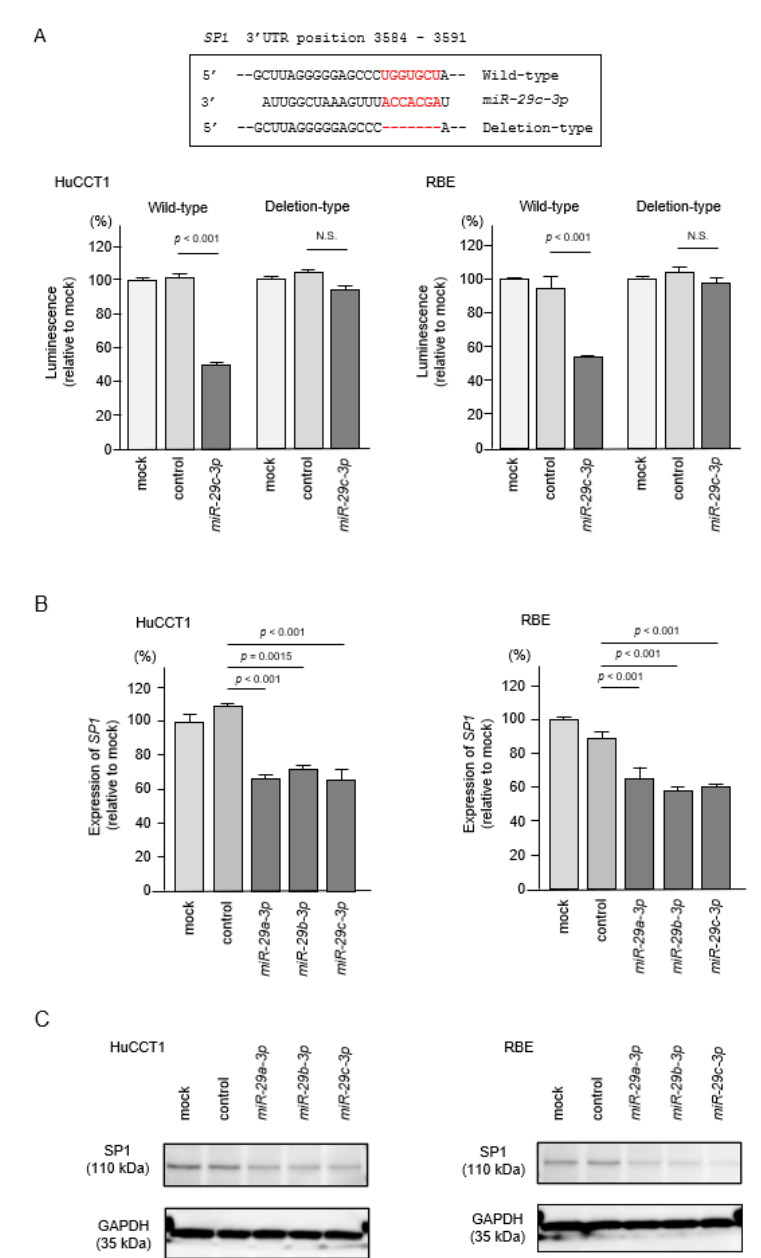
Figure 13. Direct regulation of SP1 by miR-29 -family in intrahepatic cholangiocarcinoma (ICC) cells. ( A ) The luminescence activity was reduced by co-transfection with wild-type vector (containing miR-29-3p binding site of SP1 ) and m iR-29c-3p precursor in HuCCT1 and RBE cells. In contrast, no change of luminescence activity occurred after co-transfection with deletion-type vector luciferase activity. ( B ) Expression levels of SP1 were significantly reduced by miR-29a-3p , miR-29b-3p and miR-29c-3p transfection into ICC cells. GUSB was used as an internal control. ( C ) Protein expression levels of SP1 were significantly reduced by miR-29a-3p , miR-29b-3p , and miR-29c-3p transfection into ICC cells (72 h after transfection). GAPDH was used as an internal control.